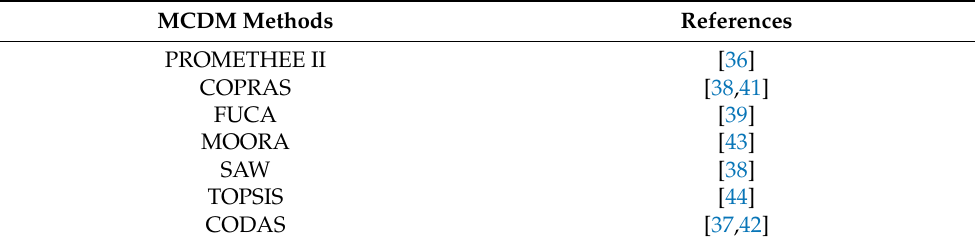
Table 4. MCDM Methods Preferred in This Study And References Based on Their Calculation.